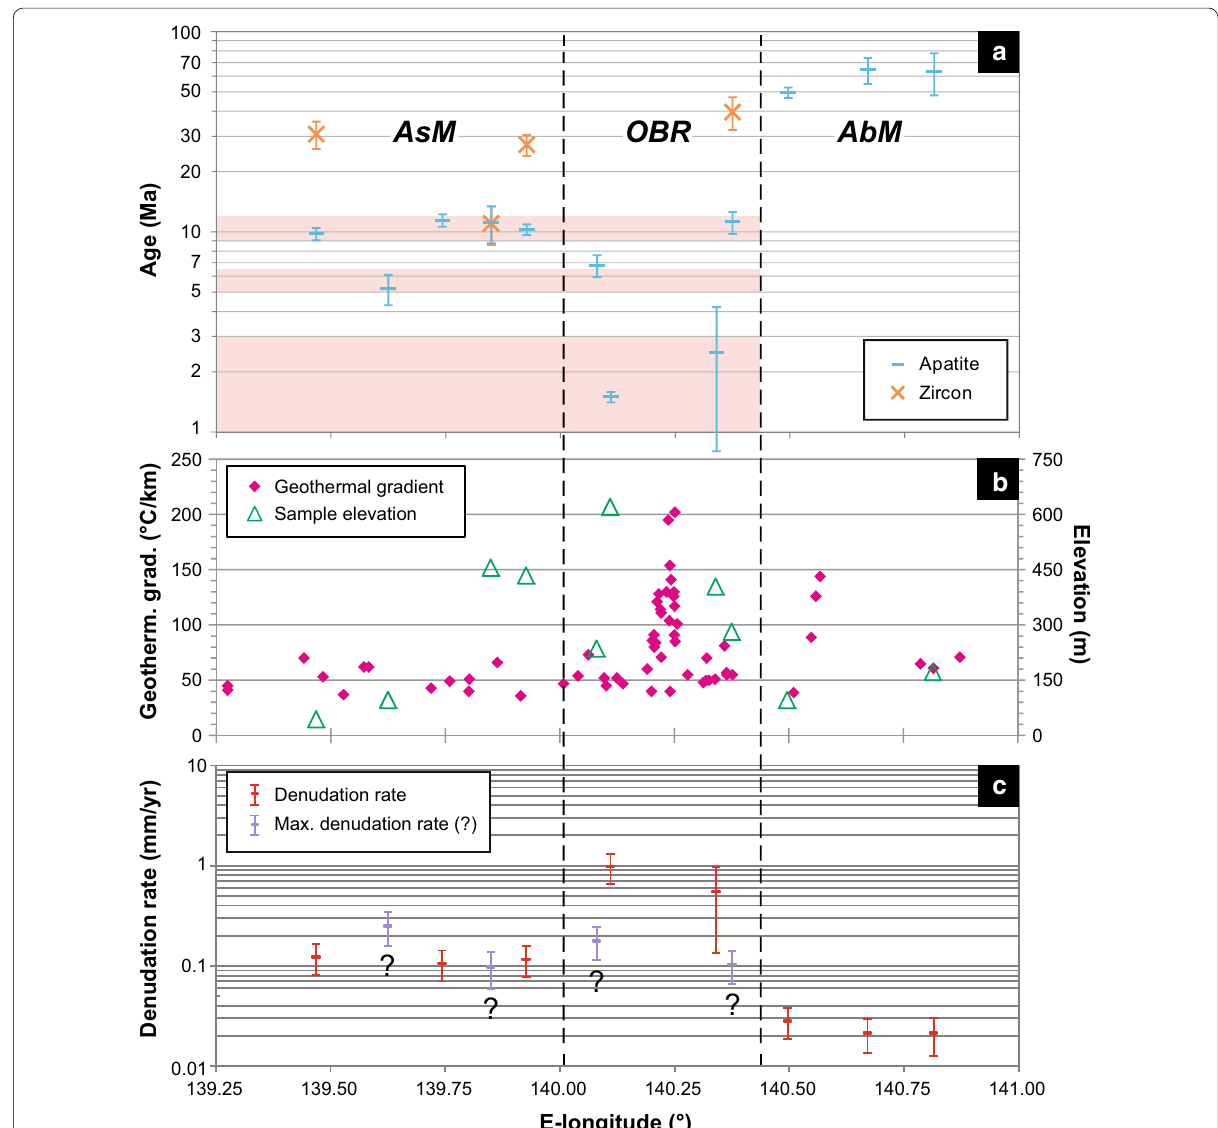
Fig. 4 a Longitude versus (U–Th)/He age. The weighted mean ages 95% confidence intervals are shown. The light pink bands indicate approxi- ± mate range of timing of the three major recent uplift episodes of the NE Japan Arc in 12–9 Ma, 6.5–5 Ma, and after 3 Ma (e.g., Nakajima et al. 2006; Fujiwara et al. 2008; Moriya et al. 2008). b Longitude versus geothermal gradient and sample elevation. Geothermal gradient data of 37.5°N–38.5°N from Tanaka et al. (2004) are plotted. c Mean denudation rates calculated from AHe ages. Purpuric data shown with “?” indicate less reliable denuda- tion rates which might reflect reheating related to magmatism; the computed denudation rates are thought to indicate the maximum